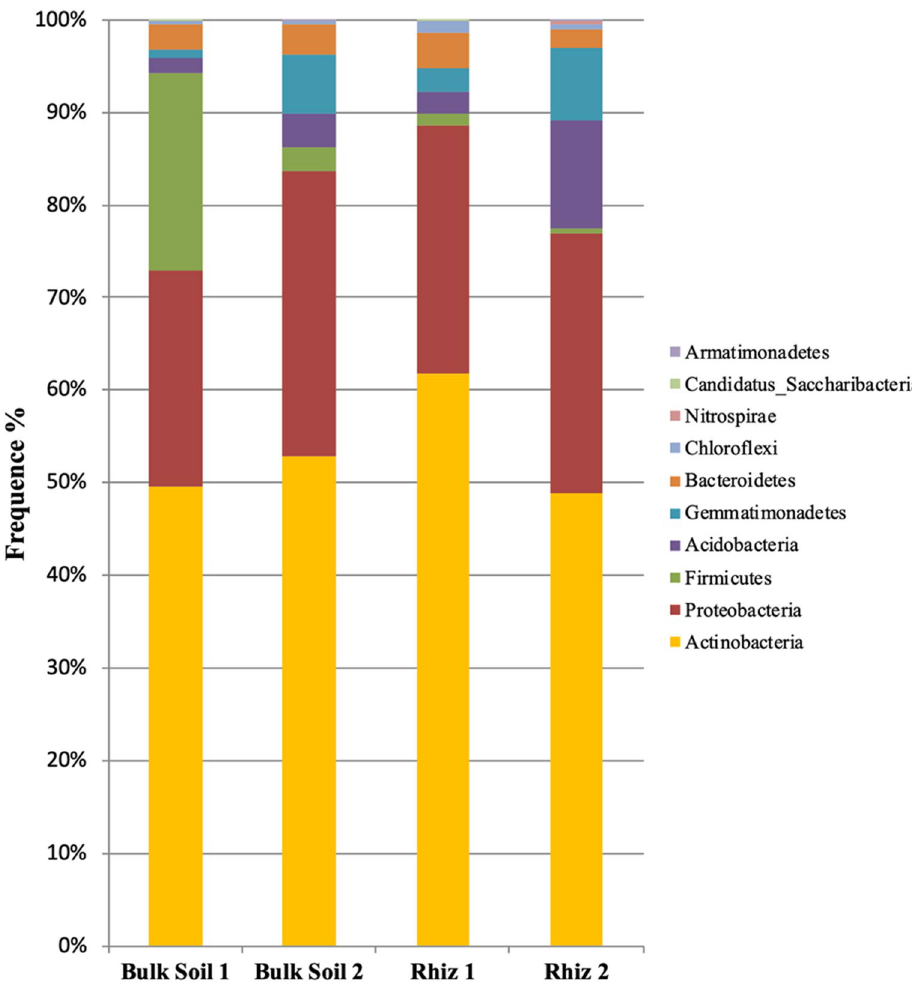
Figure 4. Microbial community composition in the bulk soil and rhizosphere of V. vinifera cv. Pinot Noir at the two sampling times (flowering and early fruiting stages) at the phylum level (top 8